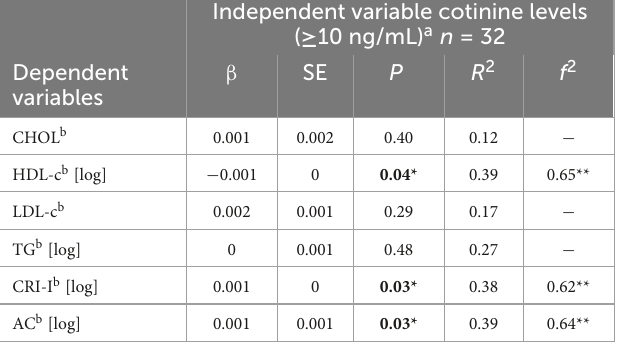
TABLE 2 Multiple linear regression analyses of the associations between serum cotinine ( ≥ 10 ng/mL) and lipid-related indices. Independent variable cotinine levels ( ≥ 10 ng/mL) a n = 32